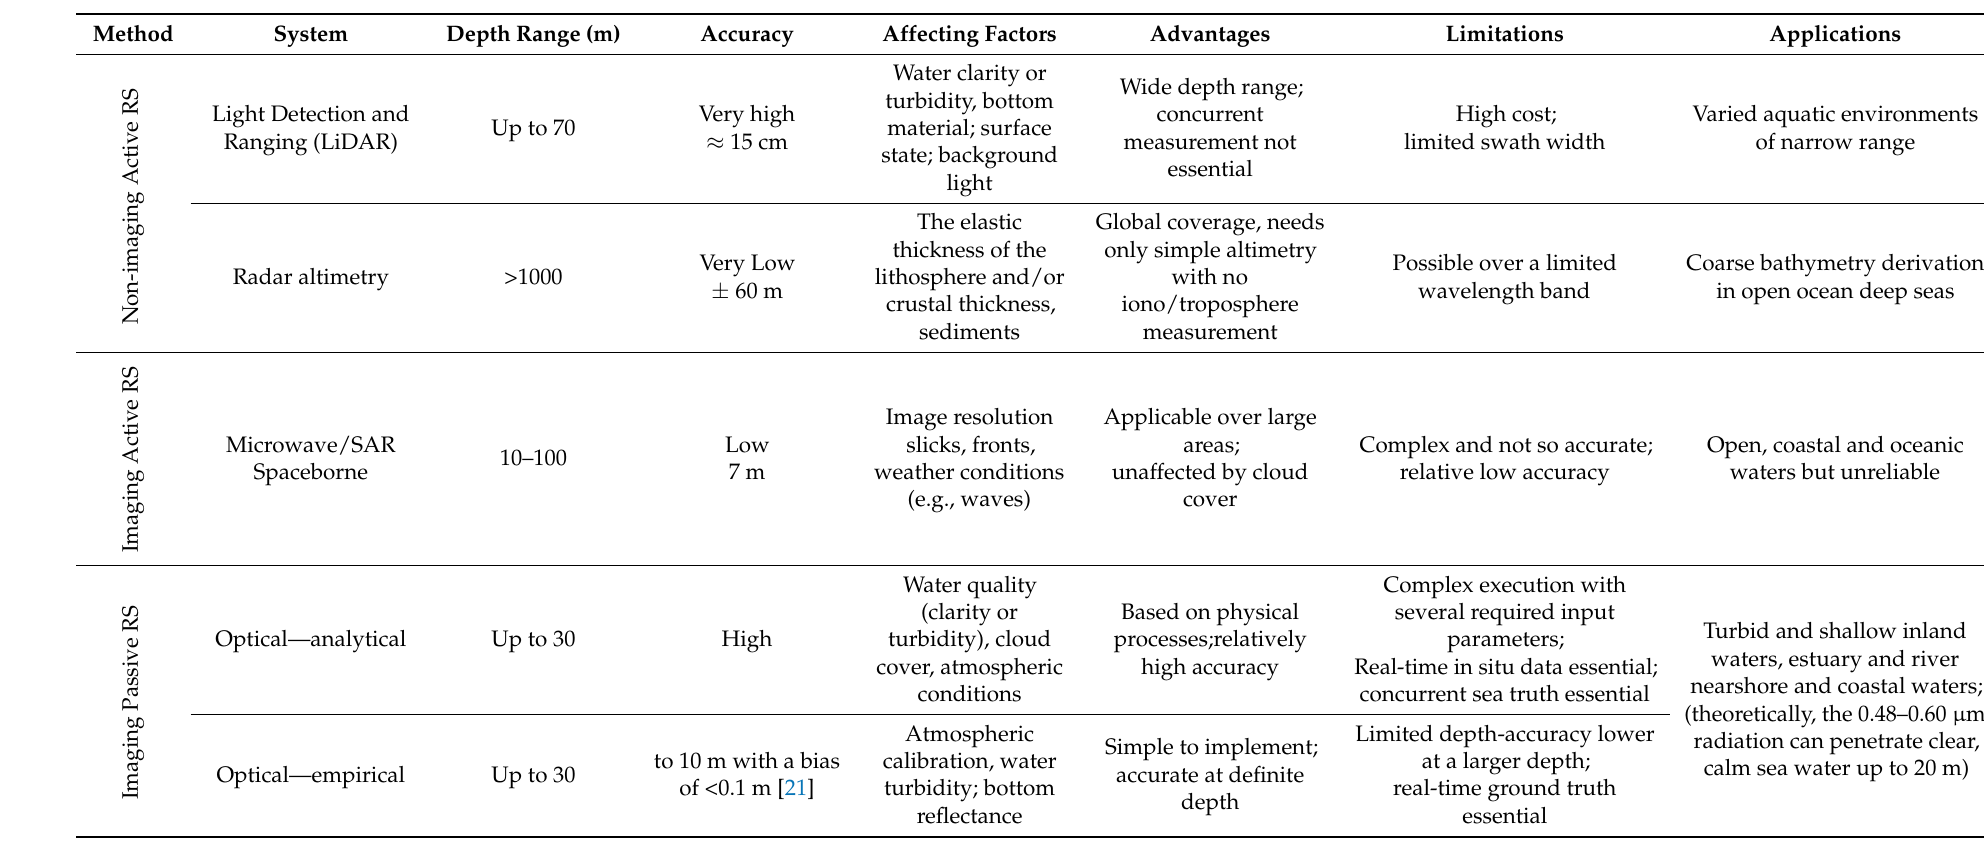
Table 1. Summary of satellite-derived bathymetry with their advantages and limitations (source: modified after